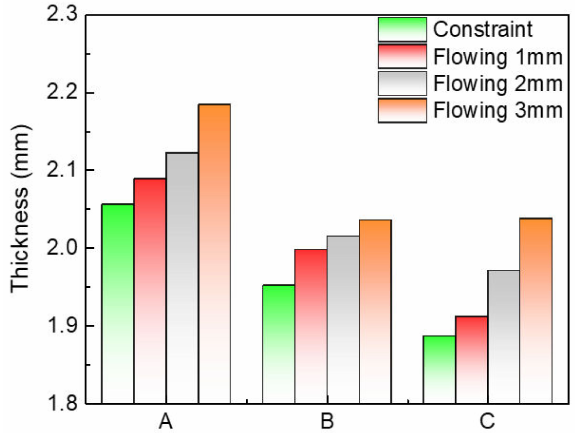
Figure 18. The thickness of point A, B, and C under different material flowing